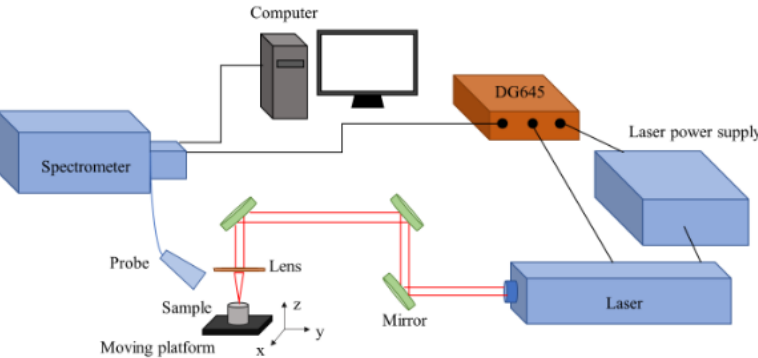
Figure 1. Schematic of the experimental setup.